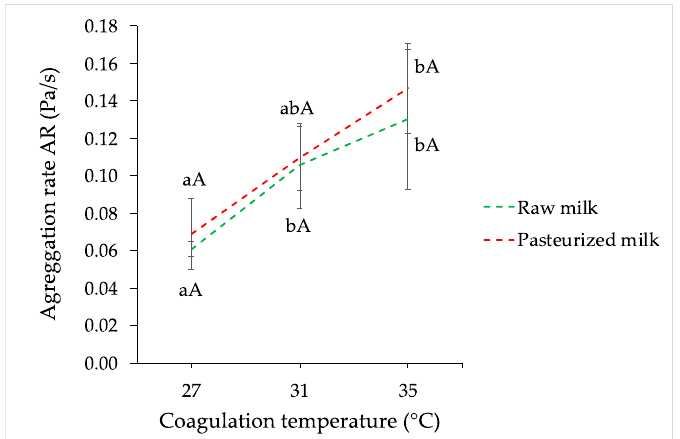
Figure 9. Influence of coagulation temperature and heat treatment of milk on aggregation rate AR (Pa/s). Values with different lowercase letters (a, b) represent differences between the coagulation temperature levels of the same milk, uppercase letters indicate no differences between milk heat treatments (raw/pasteurized). Comparison of means was performed by Tukey HSD test ( p < 0.05).